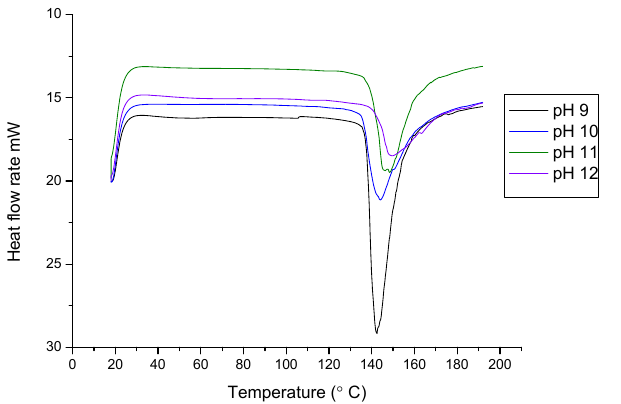
Figure 4. Differential scanning calorimetry (DSC) of FPC edible film made at pH 9, pH 10, pH 11, and pH 12.